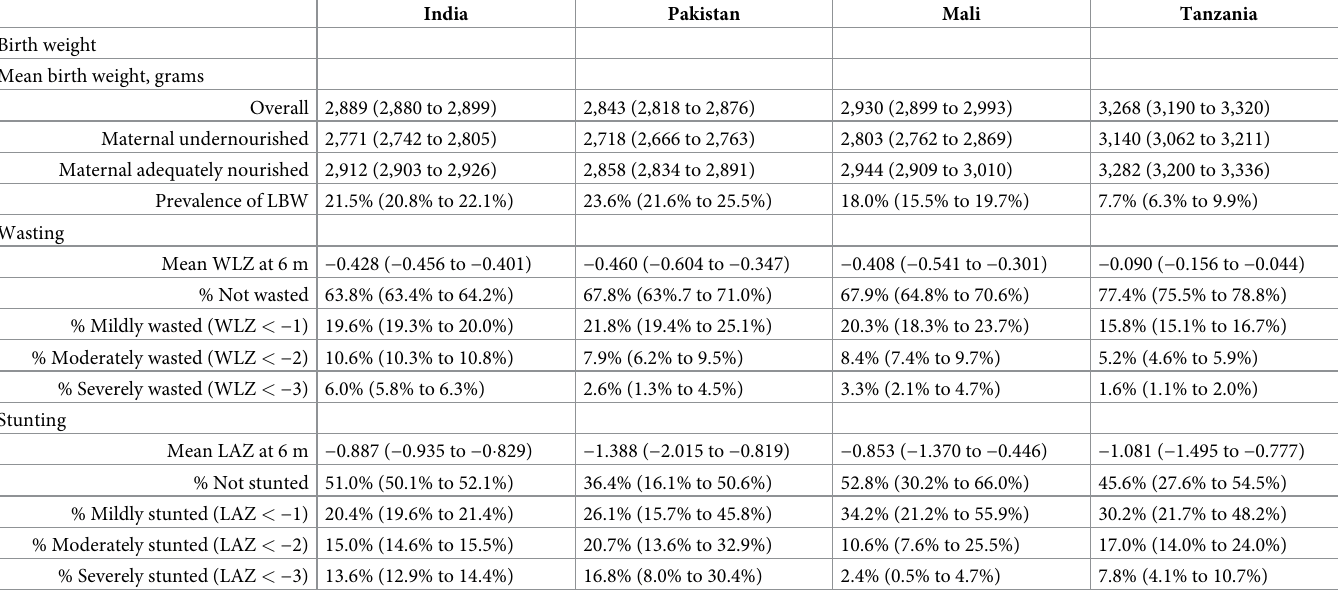
Table 3. Characteristics of baseline simulated populations of the 4 modeled countries with 95%